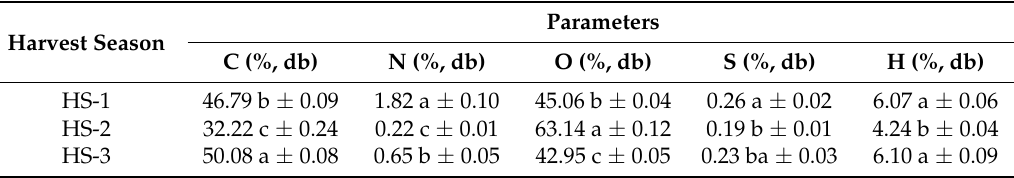
Table 3. Ultimate analysis of the investigated Sida hermaphrodita